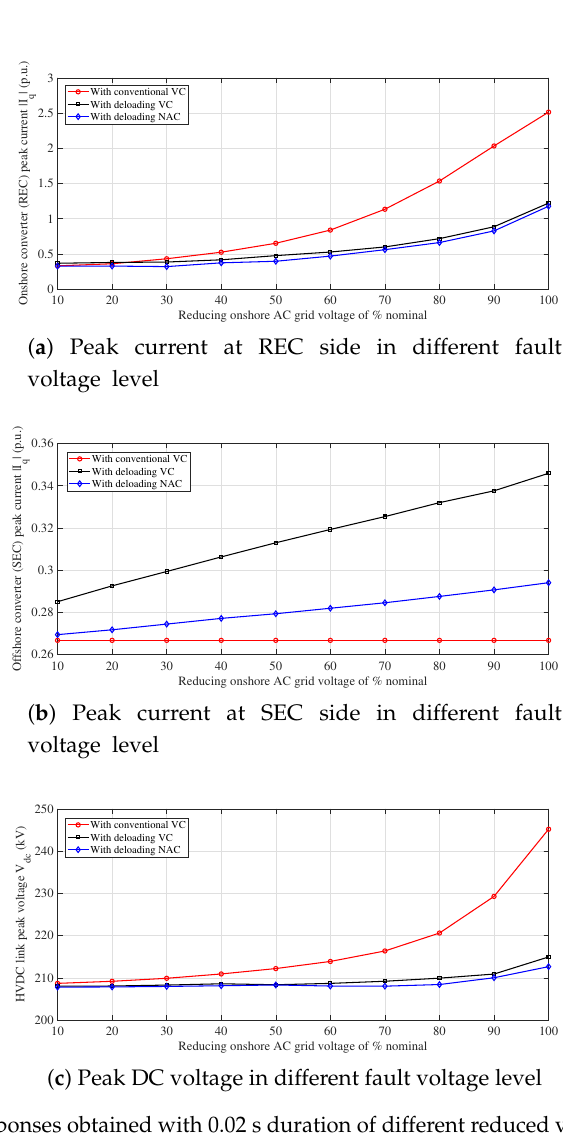
Figure 8. System responses obtained with 0.15 s duration of line-line-line-ground (LLLG) fault at onshore AC grid.